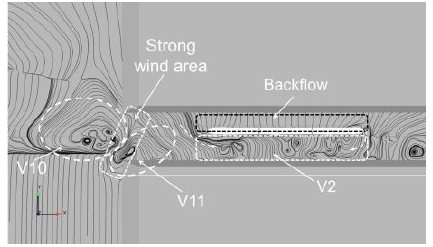
Figure 17. Top view of streamlines at a height of 0.5 h.